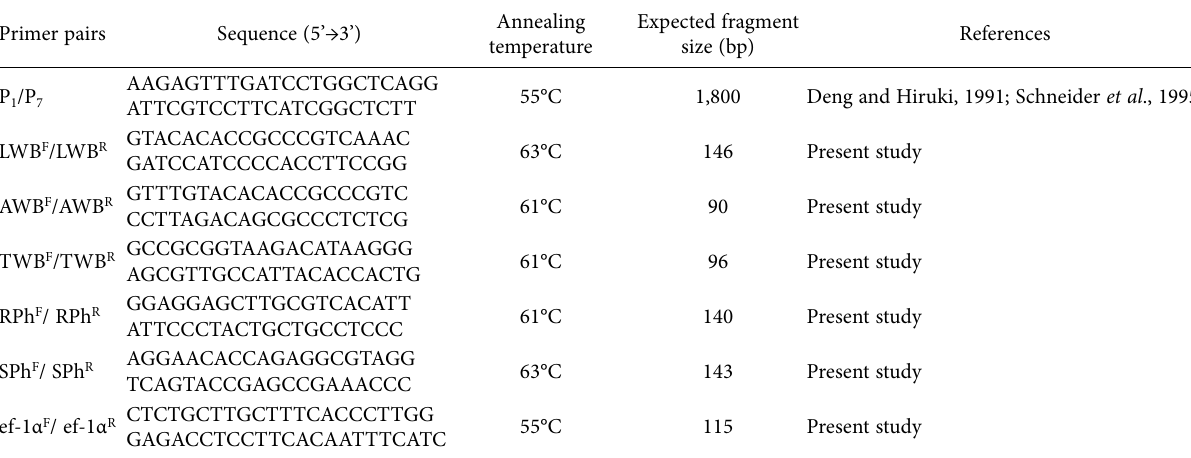
Table 1. Primers used in nested PCR and qPCR assays. Primer